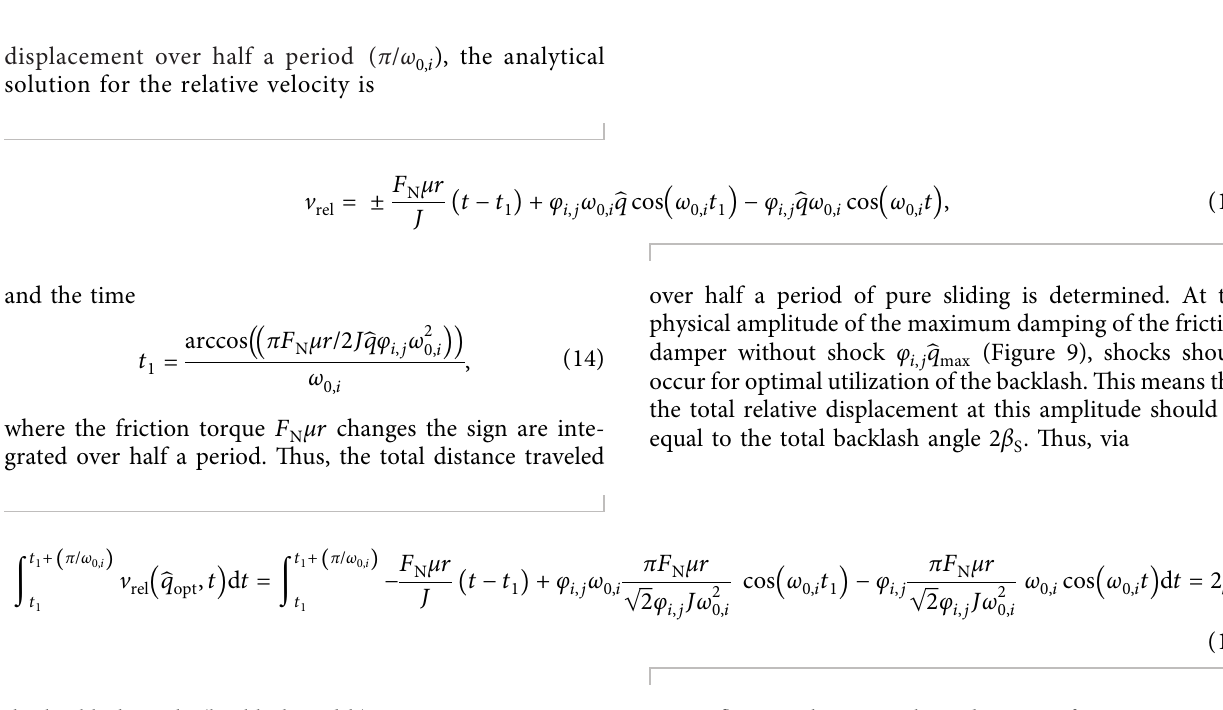
Figure 9: Semi-analytic determined damping diagram for a shock-friction